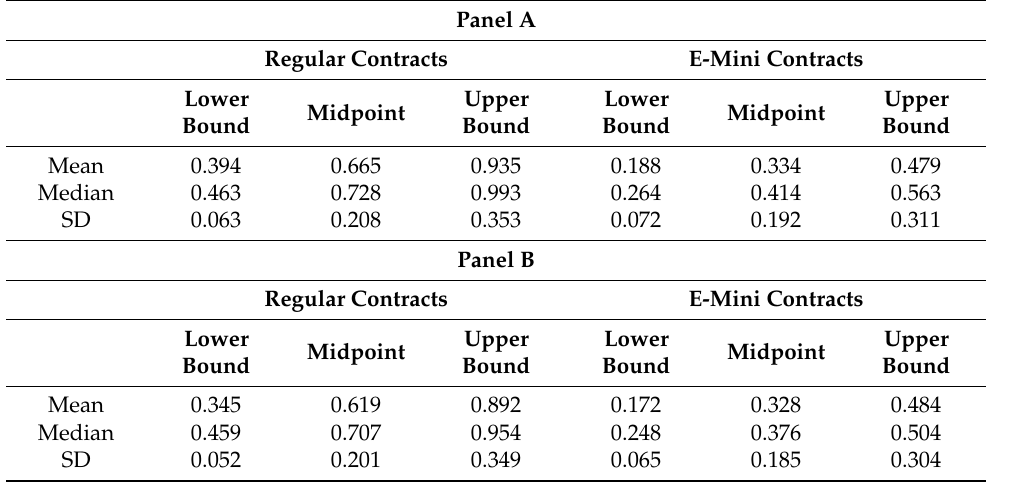
Table 3. Information shares